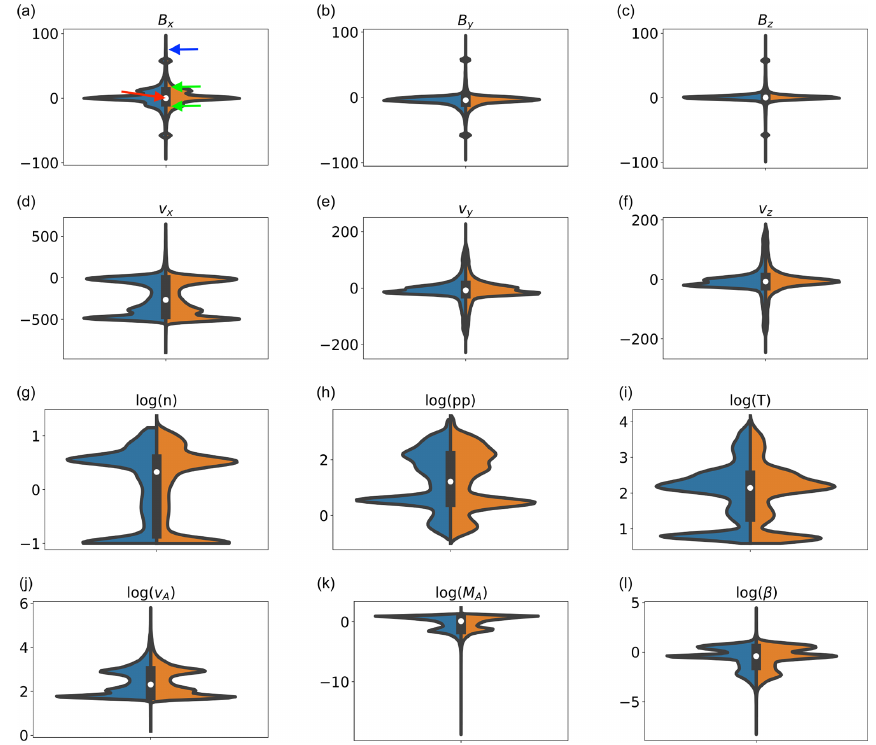
Figure 2. Violin plots of the data sets extracted from the magnetospheric simulations. The left sides of the violins, in blue, are data points at t 0 + 210min, and the right, in orange, are from t 0 + 125, 175, and 200min. In the B x plot, the red, green, and blue arrows point at the median, first and third quartiles, and whiskers,